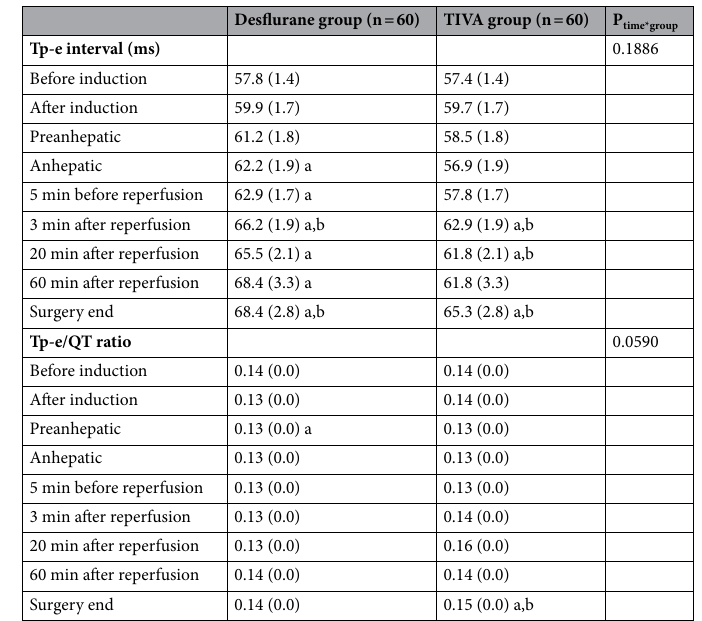
Table 2. Changes in Tpeak-Tend (Tp-e) interval and Tp-e/QT ratio during surgery. Data are presented as estimated mean (standard error). TIVA, total intravenous anesthesia. a Bonferroni-corrected P < 0.05 compared with the value of before induction in each group. b Bonferroni-corrected P < 0.05 compared with the value of 5 min before reperfusion in each group. c Bonferroni-corrected P < 0.05 compared with the TIVA